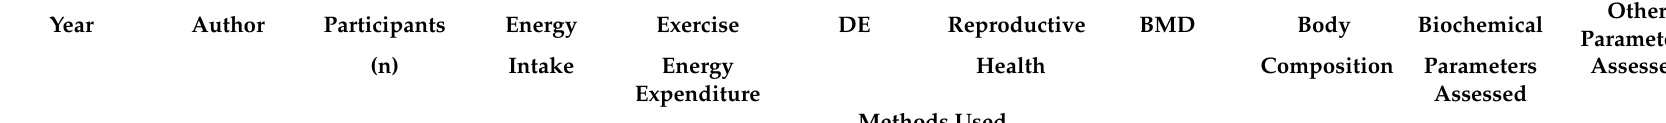
Table 2. Methods used to assess energy intake and exercise energy expenditure as part of an assessment of energy availability, disordered eating, reproductive function, bone mineral density, body composition and biochemical variables (Jan 2017–May